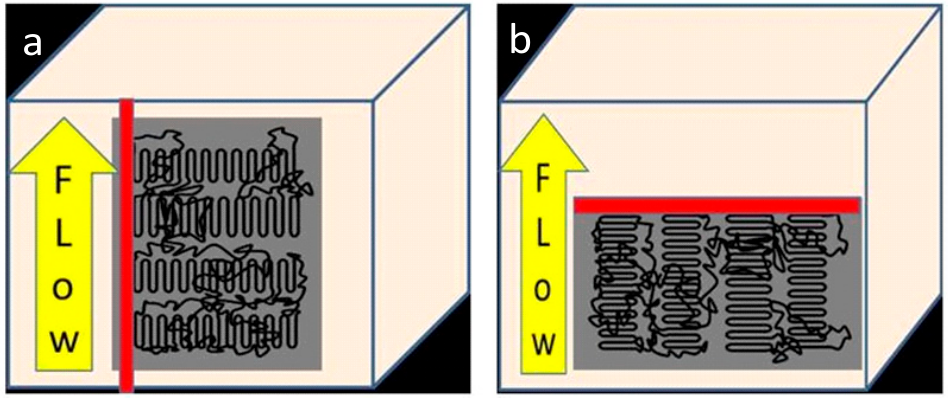
Figure 6. Schematic of the geometry of the templating mechanism for PCL/DBS. The red rod represents the DBS nanofibril aligned ( a ) ( left ) parallel with the flow direction and ( b ) ( right ) normal to the flow direction. This directs the growth direction of the lamellar crystals to be normal to the long axis of the DBS fibril as described in the text.